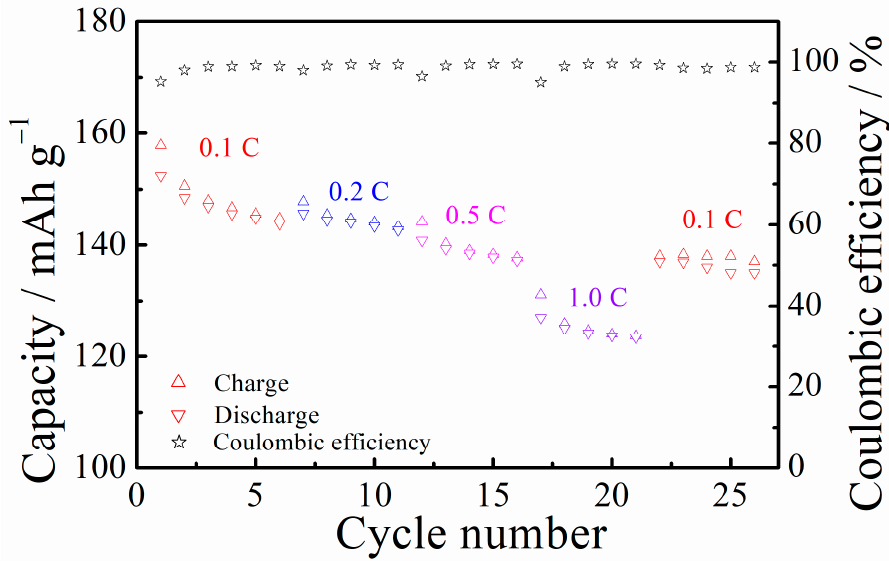
Figure 8. The rate performance of the LFP/GE/Li solid ‐ state battery.